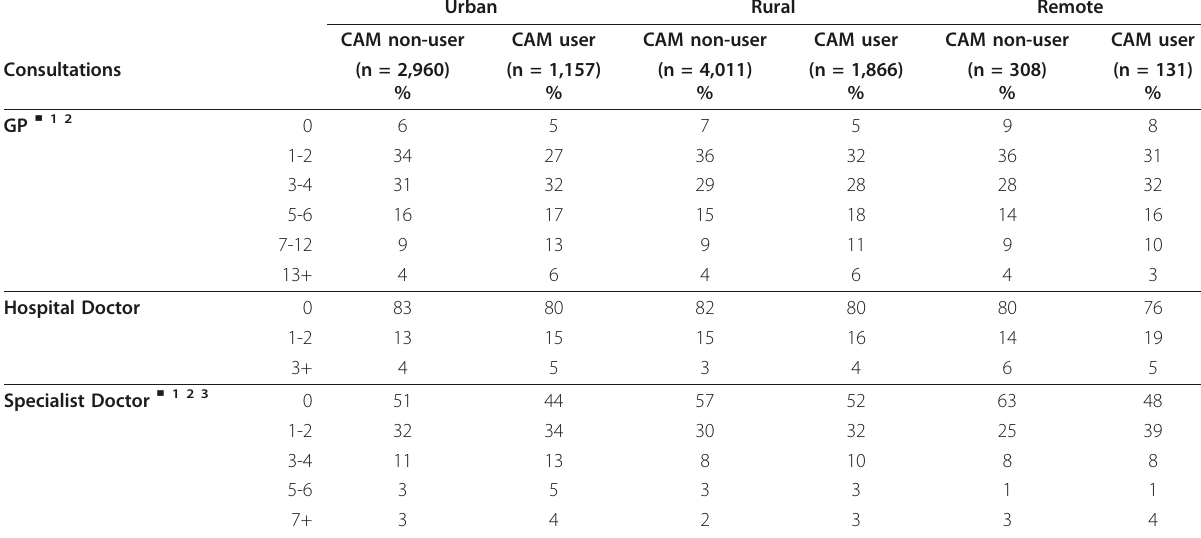
Table 1 Consultations with conventional health care providers by CAM user status (consulted with a CAM practitioner or not)